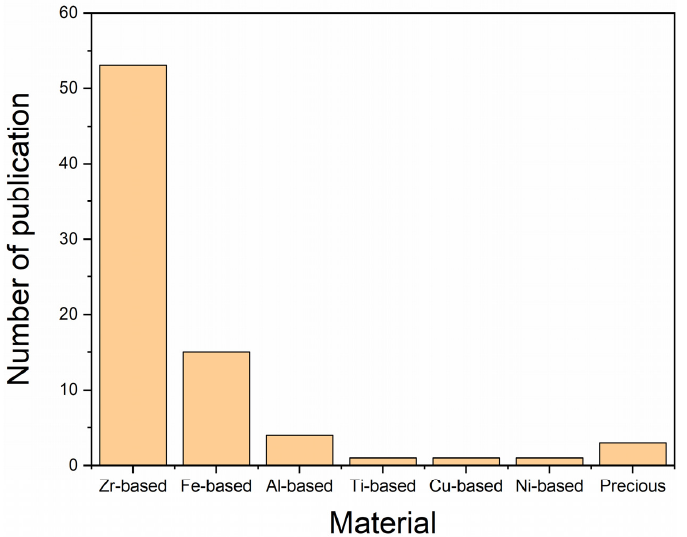
Figure 13. Number of papers related to AM of particular BMG materials from 2013 to April 2021.